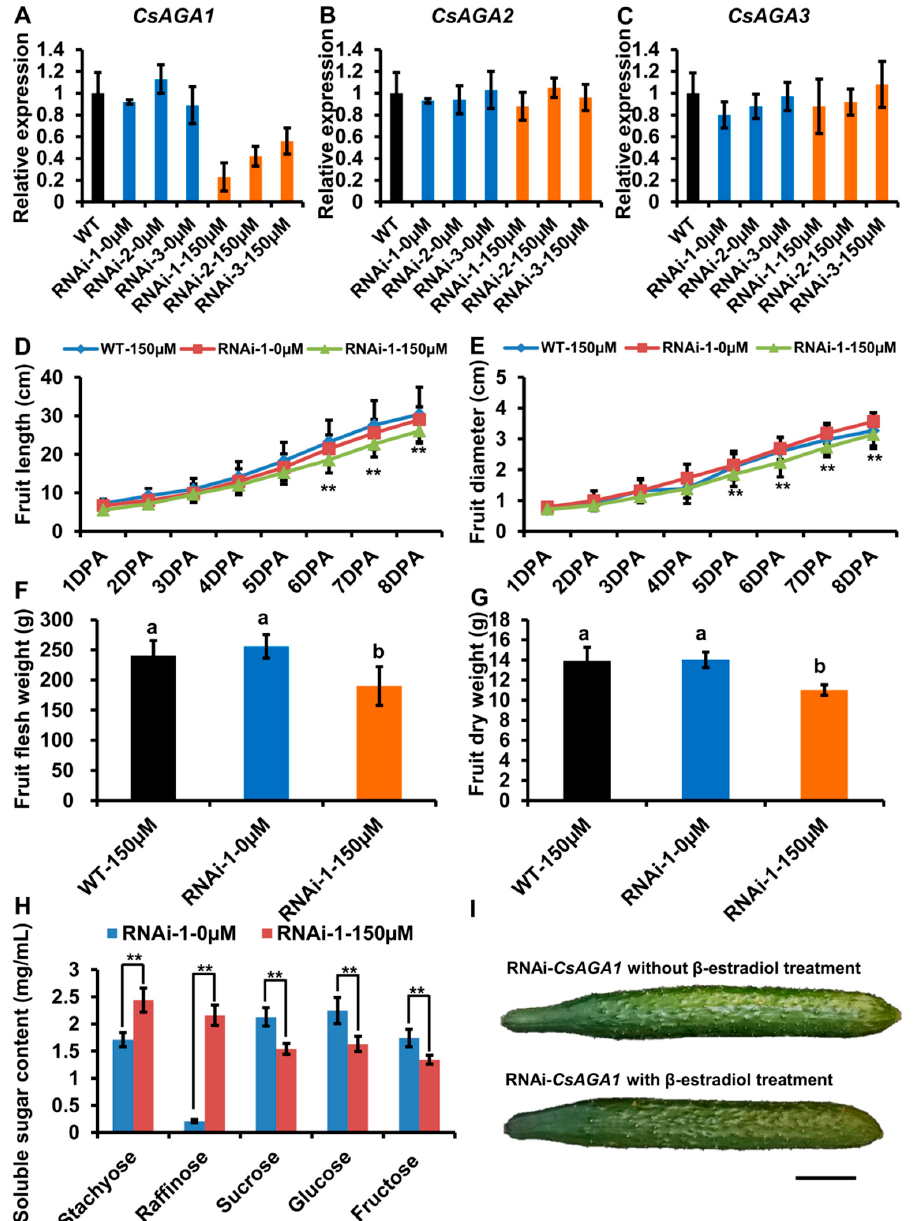
The fruit at 7DPA stage were selected for measurement. The bars represent standard deviation (SD) of 15 biological replicates. Bars marked with different letters denote significant differences ( p < 0.05) from Student’s t -test. ( H ) The analysis of soluble sugar content in RNAi- CsAGA2 plants with or without β -estradiol treatment. Soluble sugar of phloem sap was collected for measurement. Sta, Raf, Suc, Glu and Fru were measured. The bars represent standard deviation (SD) of fifteen biological replicates. Bars annotated with asterisks are significantly different according to Fisher’s least significant difference test after ANOVA (**, p < 0.01). ( I ) The fruit phenotype comparison of RNAi- CsAGA2 plants with or without β -estradiol treatment. Bar = 1 cm.